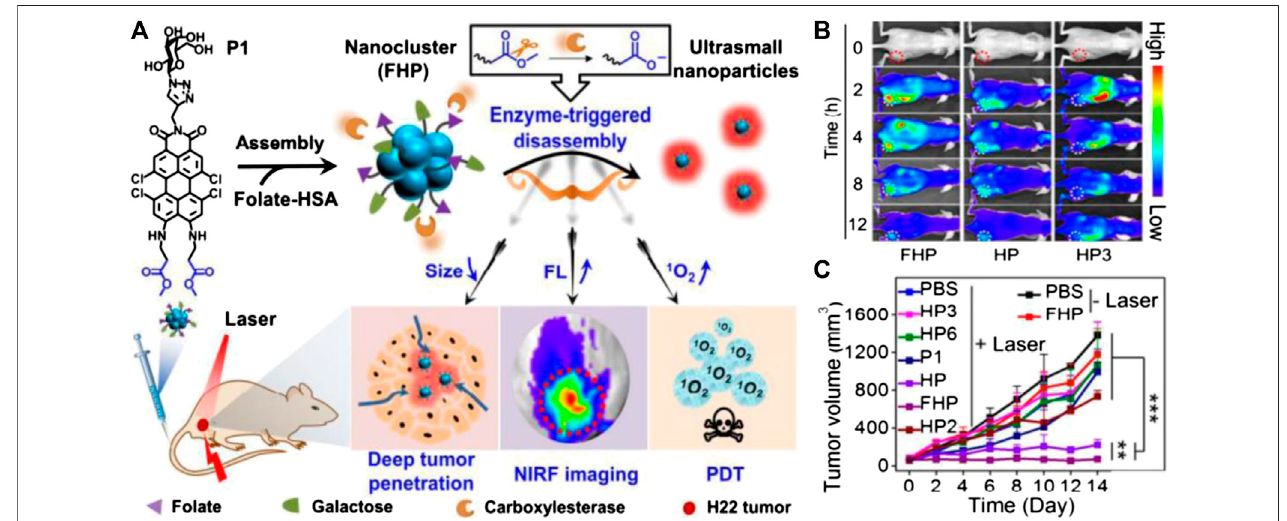
FIGURE 7 | (A) Schematic illustrations of FHP nanocluster fabrication (assembly of P1 and folate-modi fi ed human serum albumin (HSA)), enzyme-triggered disassembly of FHP with size shrinkage for deep tumor penetration, and activatable photoactivity for near-infrared fl uorescence (NIRF) imaging-guided deep PDT. (B) Real-time monitoring of fl uorescence images in vivo of tumor-bearing mice after intravenous injection of FHP, HP, and HP3 (3.75 mg kg − 1 per injection). (C) Tumor growth curves of H22 tumor-bearing mice treated with various agents. Reproduced with permission from Tang et al. (2019). Copyright 2020 Wiley-VCH Verlag GmbH & Co.